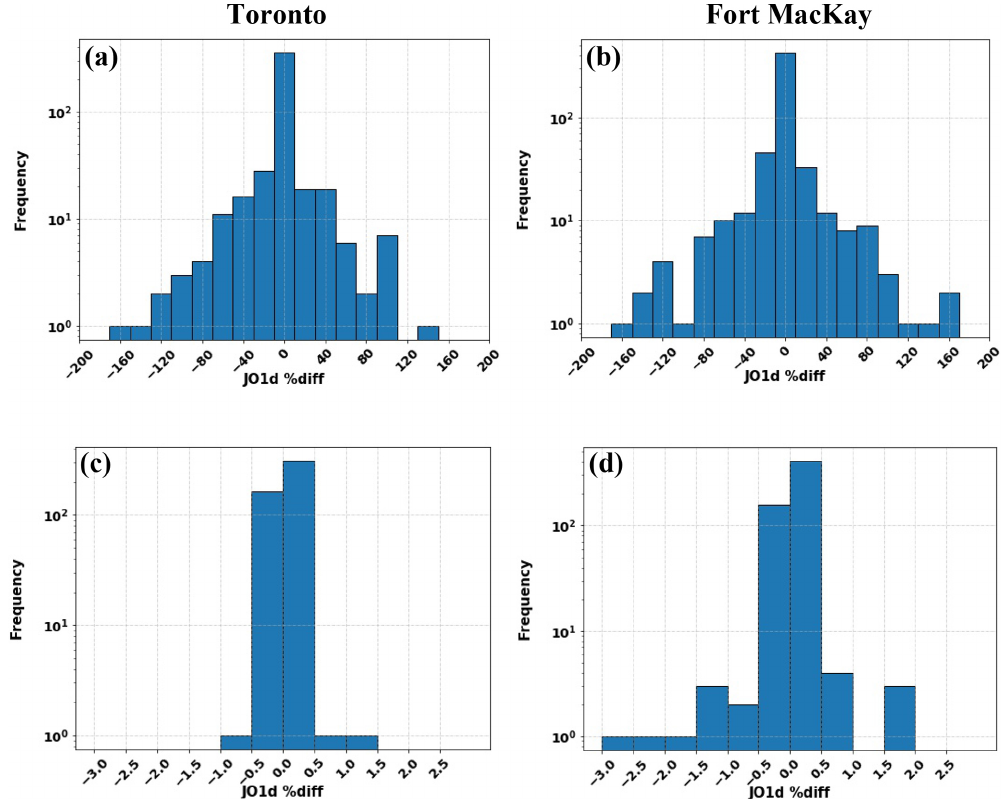
Figure 12. Histograms of percentage difference of hourly J O 1 D output for June 2018 at the Toronto and Fort McKay AERONET stations at the lowest model level, with and without AOD calculations. Panels (a, b) are with aerosol feedbacks, and panels (c, d) are without aerosol feedbacks. Nighttime data ( J O 1 D = 0) were omitted from the